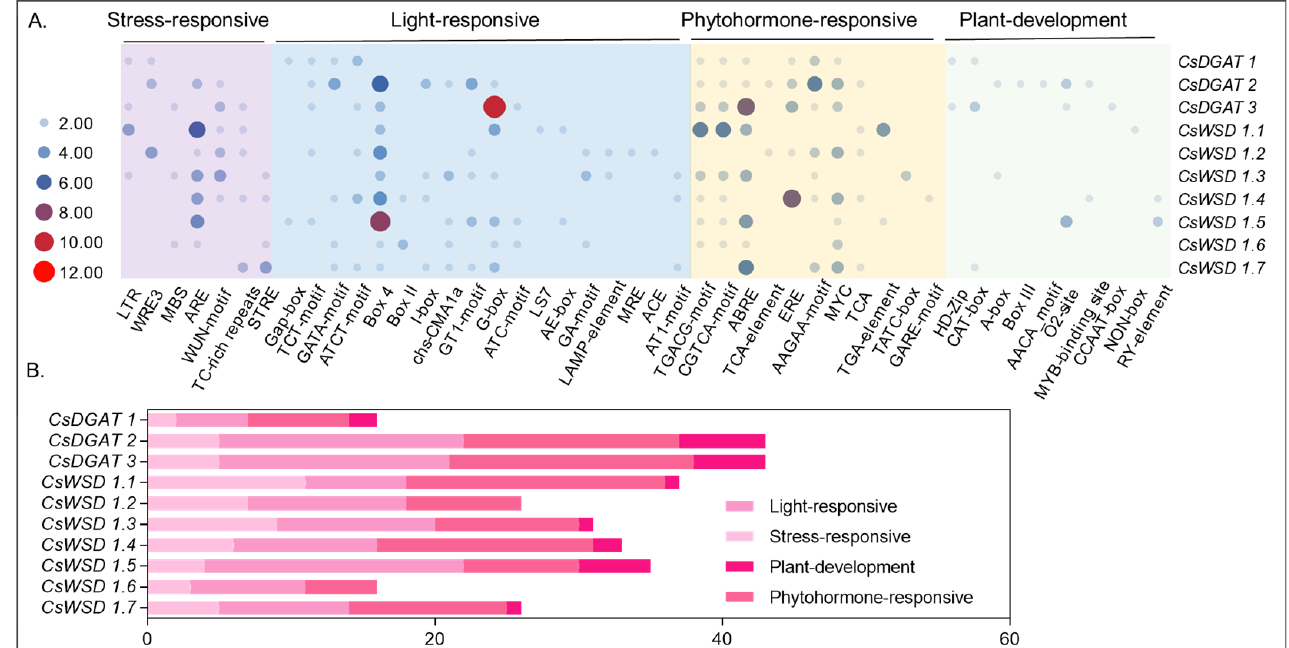
Figure 4. The schematic model of Cis -acting elements distribution pattern in 10 CsDGATs gene promoter regions. ( A ) These cis -acting elements were classified into four groups: stress-responsive, light-responsive, phytohormone-responsive, and plant-responsive, as shown in the heatmap. ( B ) The total count of these four categories is displayed in the bar plot.